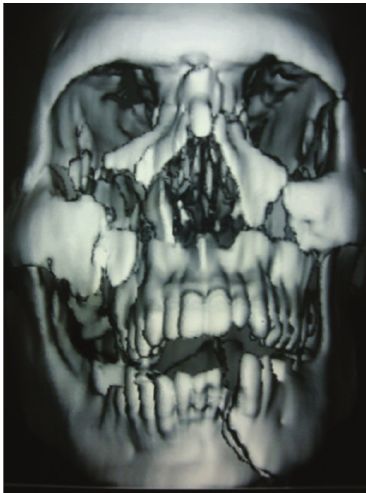
Figure 2: Three-dimensional computed tomography scan showing multiple fractures of jaw bone.